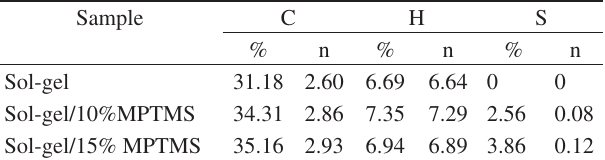
Table 1. Elemental analysis (%) and number of mol for each element per 100 grams (n) of the sol-gel, sol-gel functionalised with 10% and 15% of MPTMS